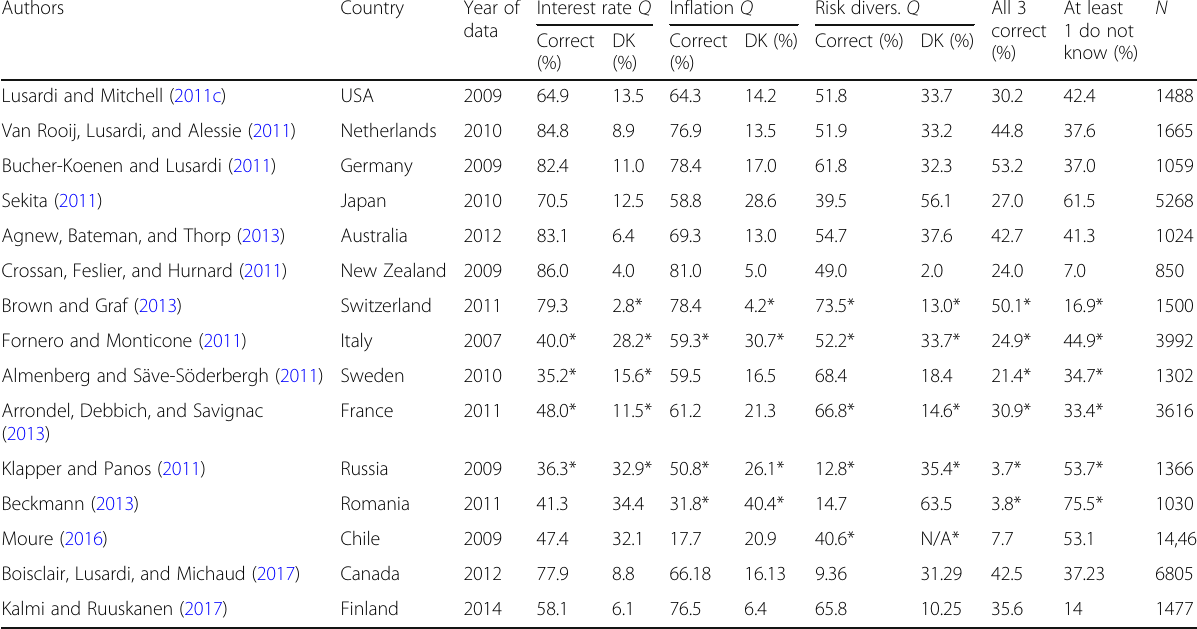
Table 2 Findings from the FLat World project across 15 countries